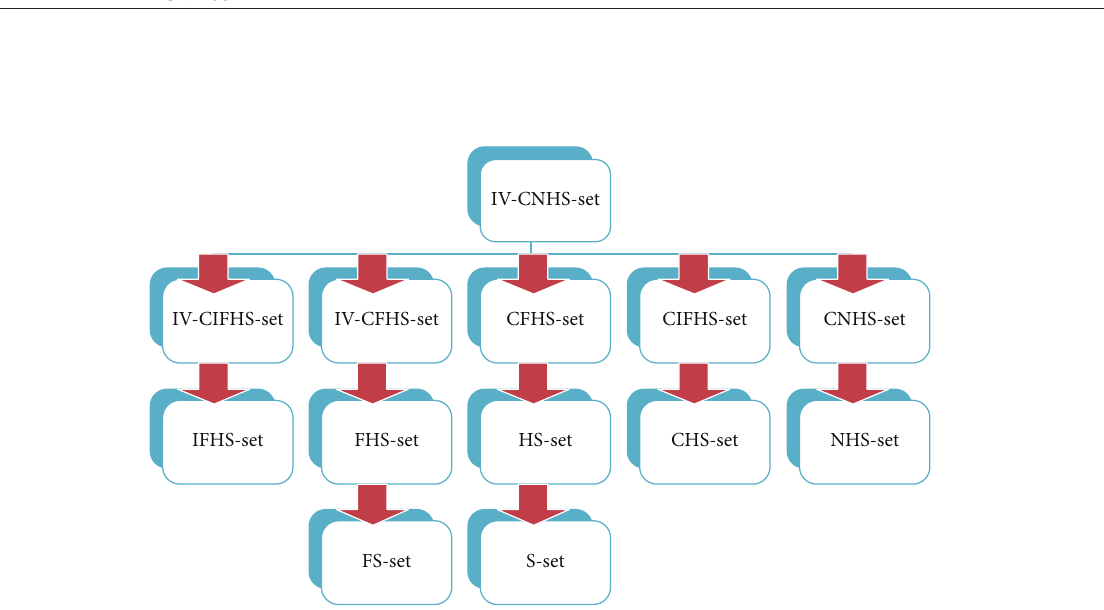
Figure 3: Generalization of the proposed